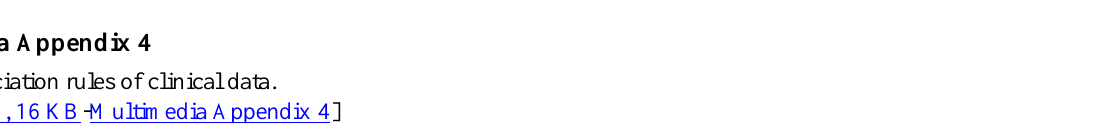
Supplementary Table 2. Lesion and interventional procedure